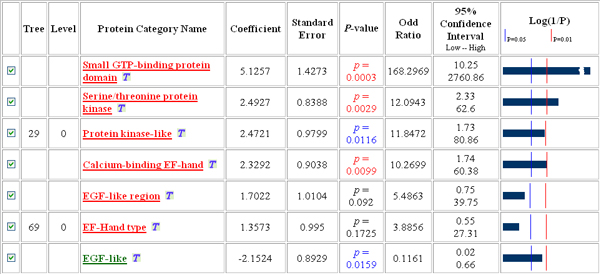
GFINDer Logistic Regression module: selected protein domains. InterPro protein domains (Protein Category Name) with a relevant logistic regression coefficient and codified by the considered neurobiology or cardiovascular system related genes; Tree: tree label in the defined protein domain parent/child hierarchy, if any; Level: level in the related tree of the defined protein domain parent/child hierarchy, if any (higher levels correspond to more specific protein domains).